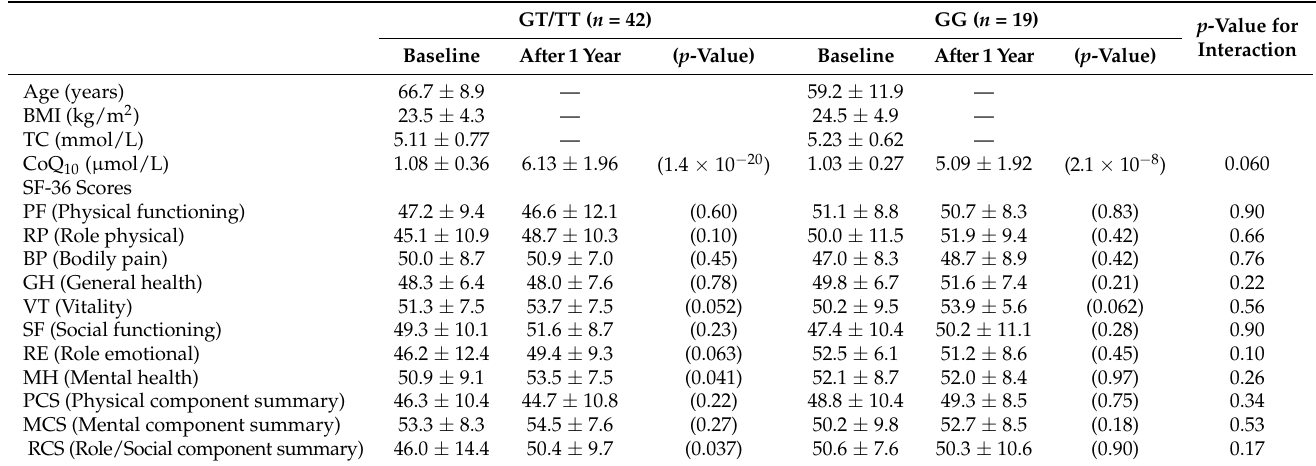
Table 2. Changes in the measurements of rs3808607 (G > T) in CYP7A1 during the reduced CoQ 10 supplementation in